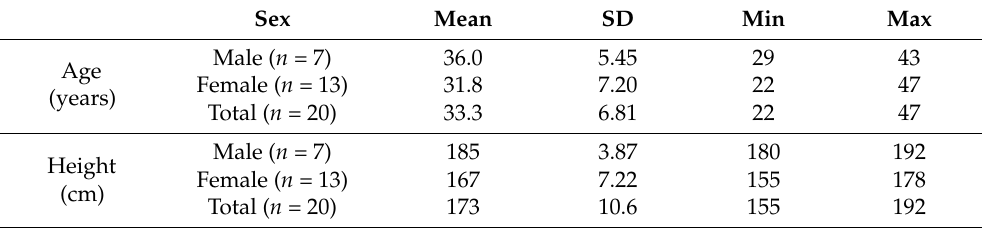
Table 2. Participant demographic